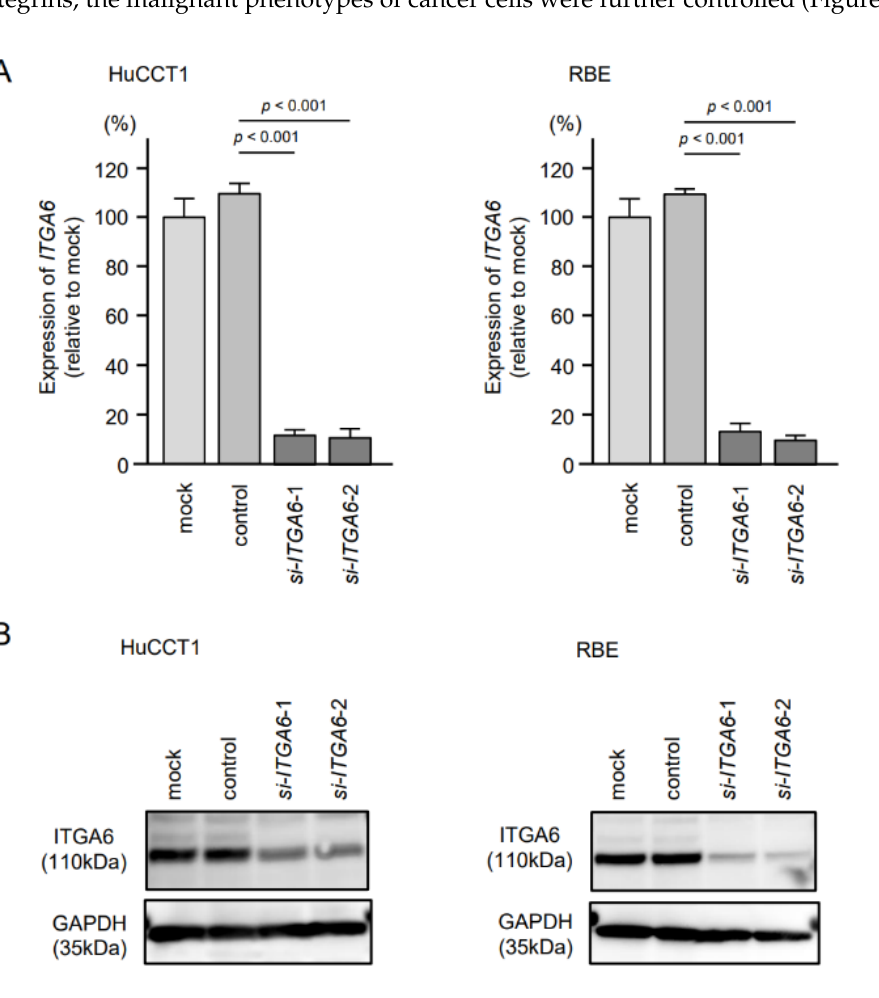
Figure 8. Knockdown efficiency of si ITGA6 in HuCCt1 and RBE cells. ( A ) Expression of ITGA6 in ICC cell lines was evaluated 72 h after transfection with si-ITGA6-1 or si-ITGA6-2 . GUSB was used as an internal control. ( B ) Expression of ITGA6 in ICC cell lines was evaluated by Western blot analysis 72 h after transfection with si-ITGA6-1 or si-ITGA6-2 . GAPDH was used as internal con- trol.